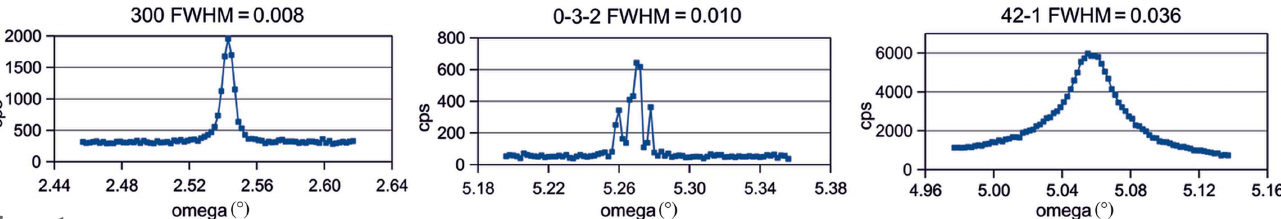
Figure 1 Representative high-resolution scans for three types of reflections. 300 and 0-3-2 comply with parity rule h (cid:2) k = 3 n , while 42-1 disobeys the rule. Moreover, the 0-3-2 reflection shows micro-splitting because of the misalignment of tiny kaliophilite domains. Note that the abscissa has the same scale in all cases and (cid:7) = 0.6888 A˚